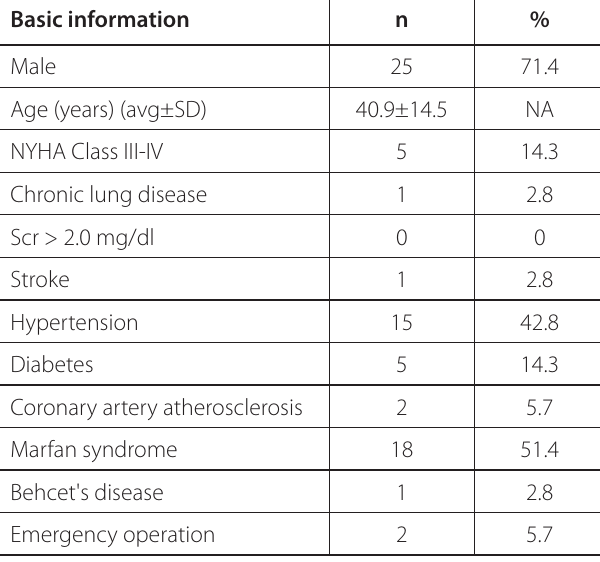
Table 1 . Baseline clinical characteristics of 35 cases of reoperation.